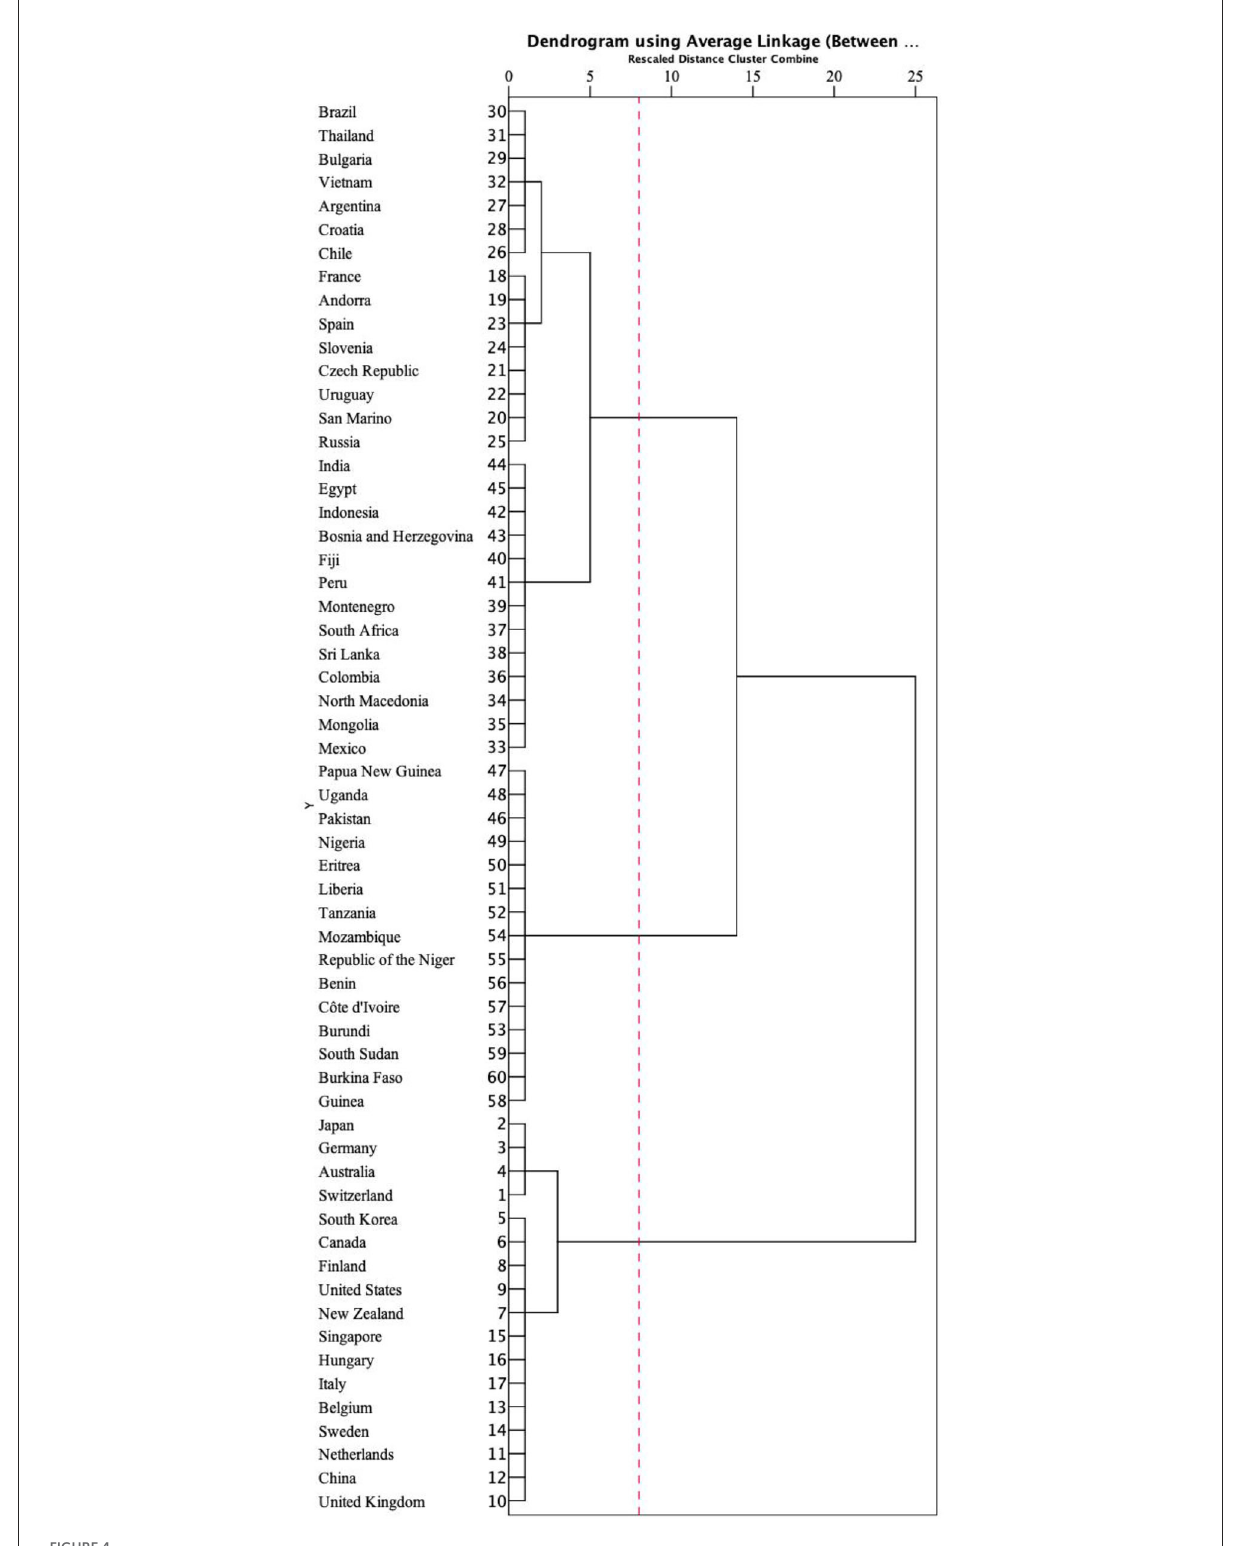
FIGURE4 Clustering spectrum